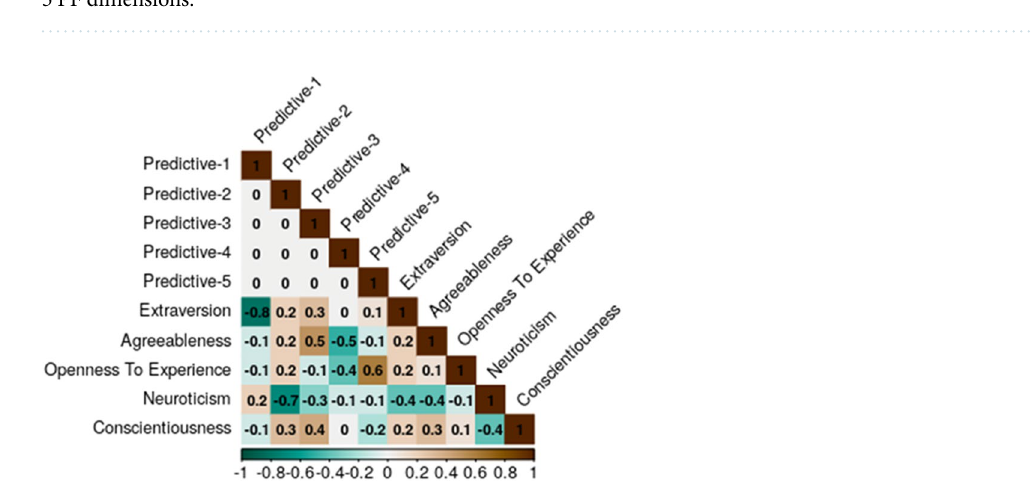
Figure 2. Correlations between the PF and FFM scale